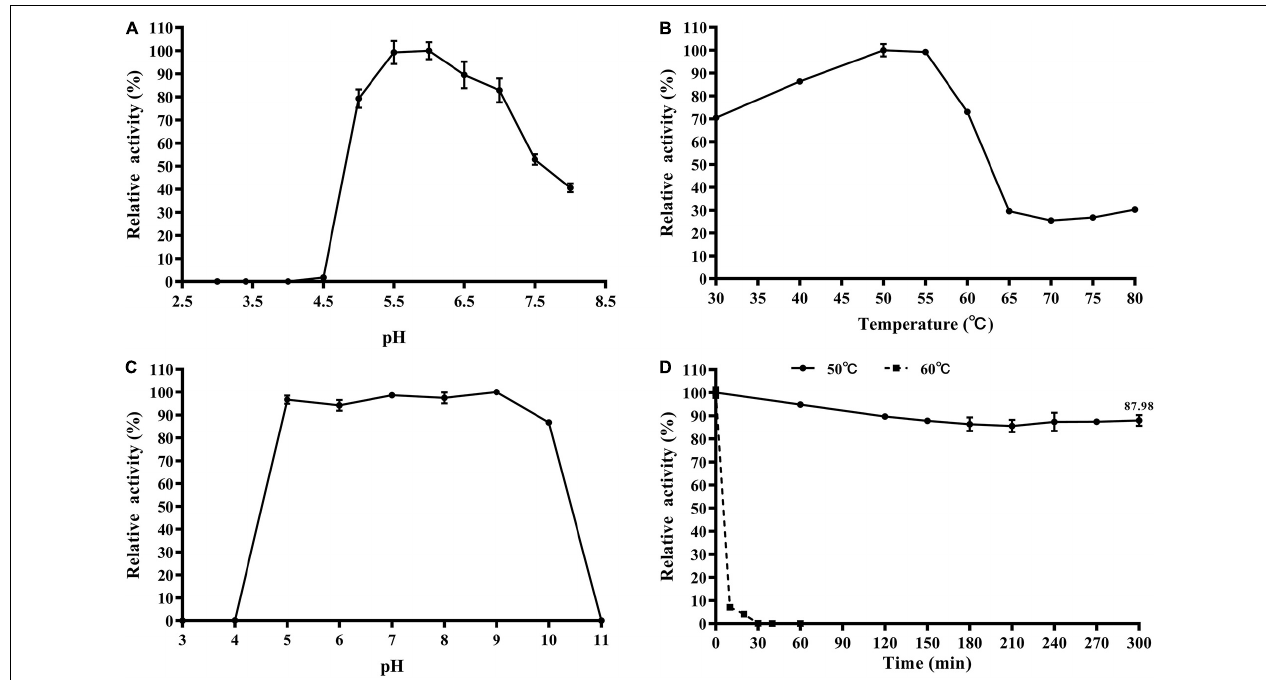
FIGURE 3 | Biochemical characterization of the recombinant TtBgl3. The optimum pH (A) and temperature (B) of the recombinant TtBgl3 using p NPG as substrate. The effects of pH (C) and temperature (D) on the stability of TtBgl3.